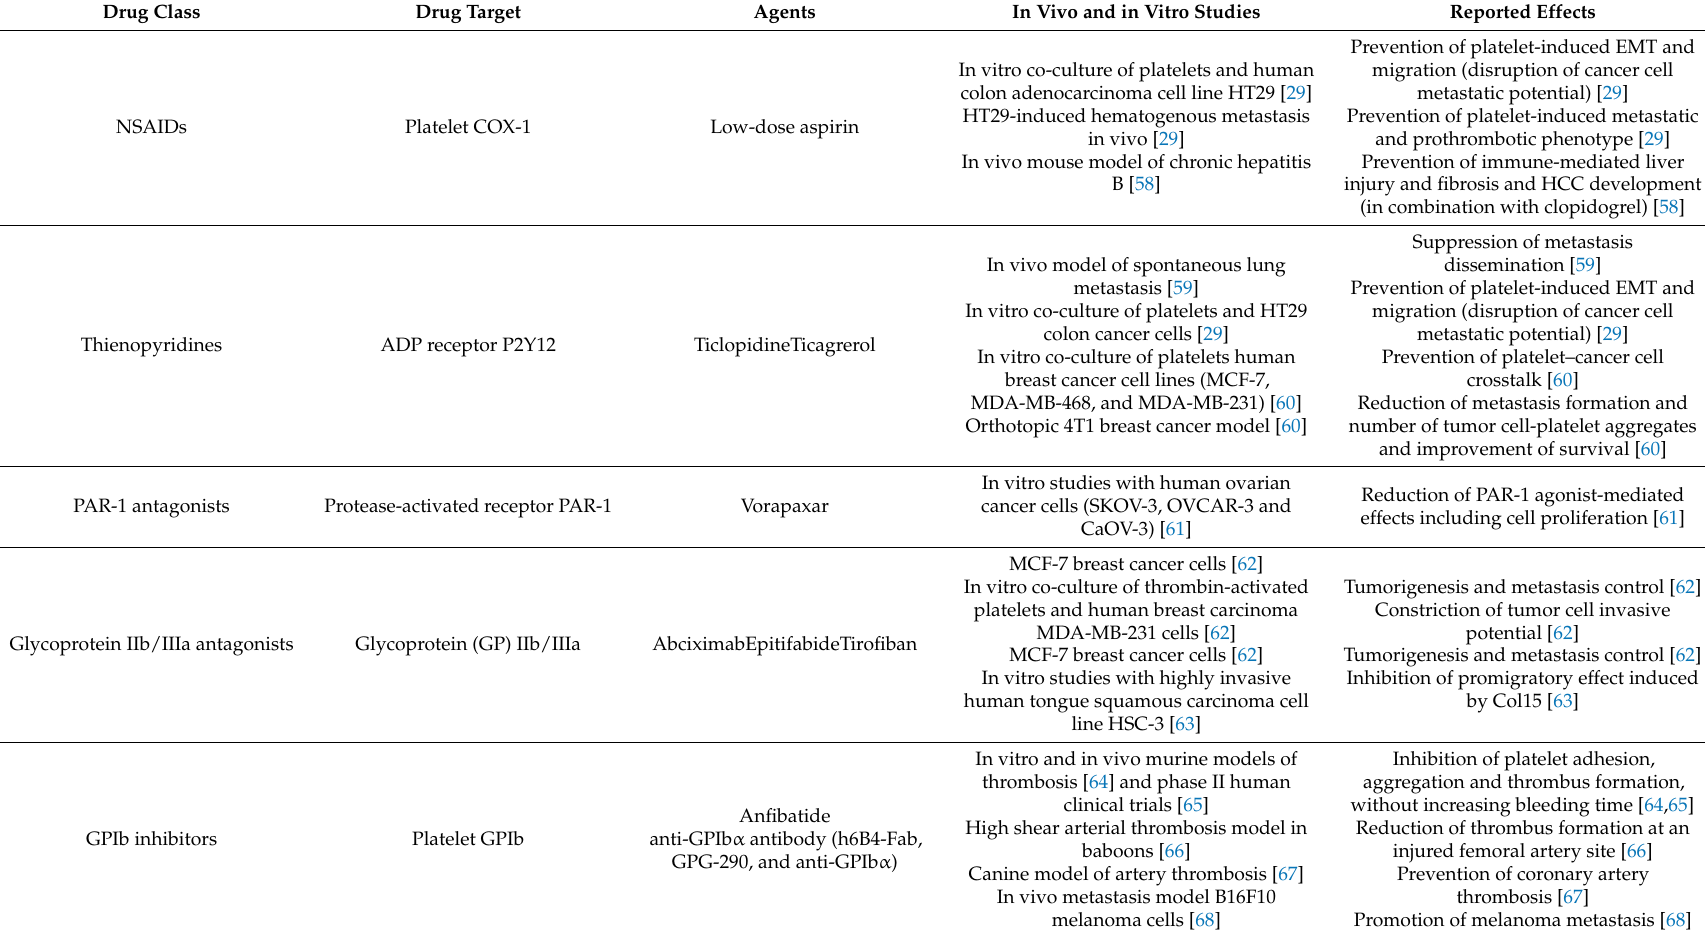
Table 1. Effects of antiplatelet agents on tumorigenesis and metastasis formation: in vitro and in vivo